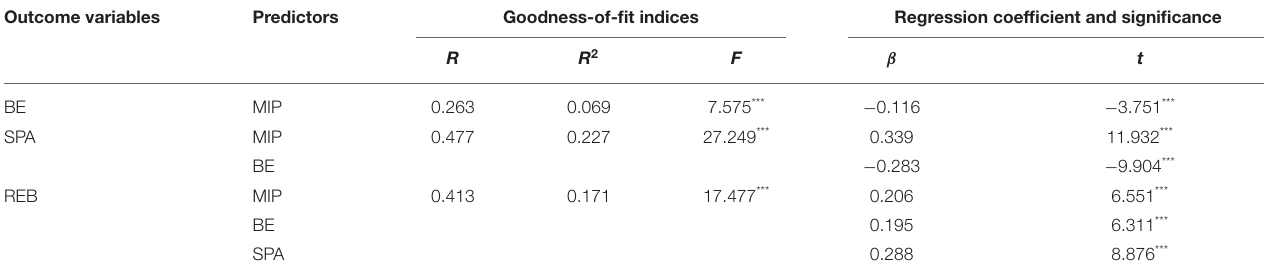
TABLE 3 | The results of the regression estimate of the chained mediation model. Outcome